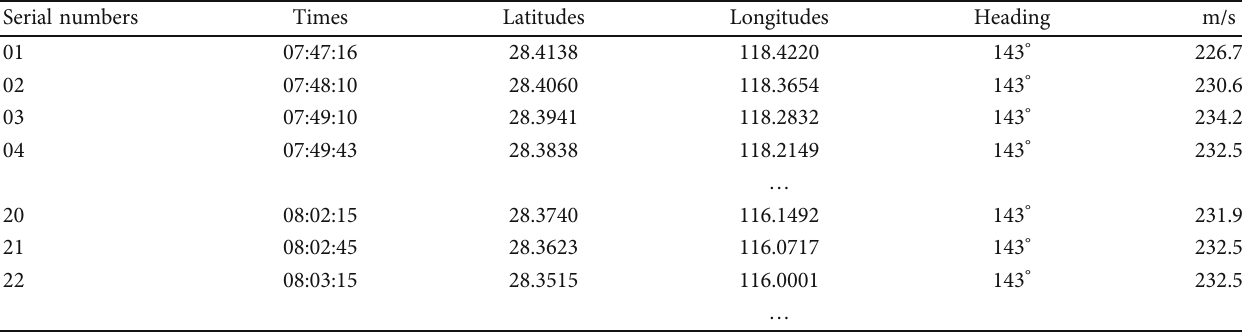
Table 2: Part of B737-800 location time information table based on ADS-B.